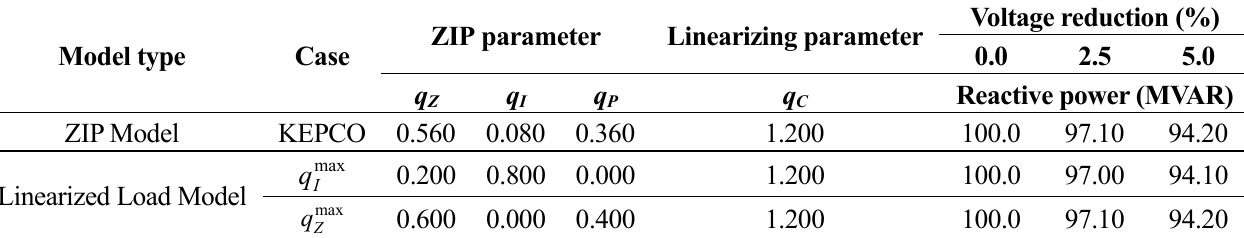
Table 2. Reactive power variations due to voltage reductions with different reactive ZIP